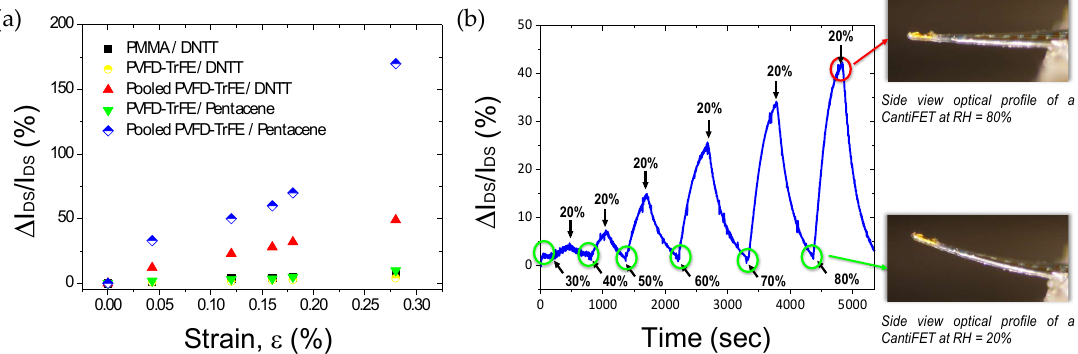
Figure 4. ( a ) Relative changes of drain current (∆ I DS / I DS ) as a function of applied strain for different coupled gate dielectric/OSC layers in OFET-embedded cantilever; ( b ) (∆ I DS / I DS ) plotted versus elapsed time for different levels of relative humidity by steps of 10%. Black arrows correspond to the instruction of humidity level set by the environmental chamber.